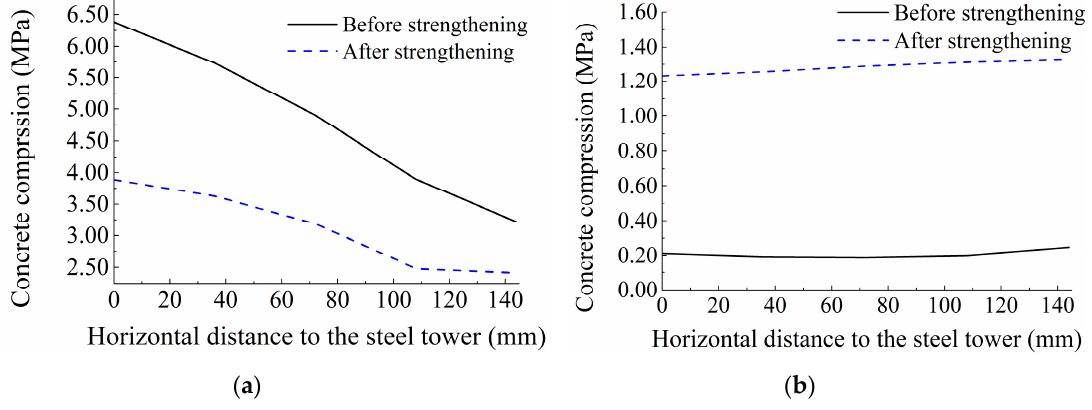
Figure 14. Comparison of windward-side compressive stress above the T-shaped plate under fatigue loading. ( a ) Under the peak value; ( b ) Under the valley value.